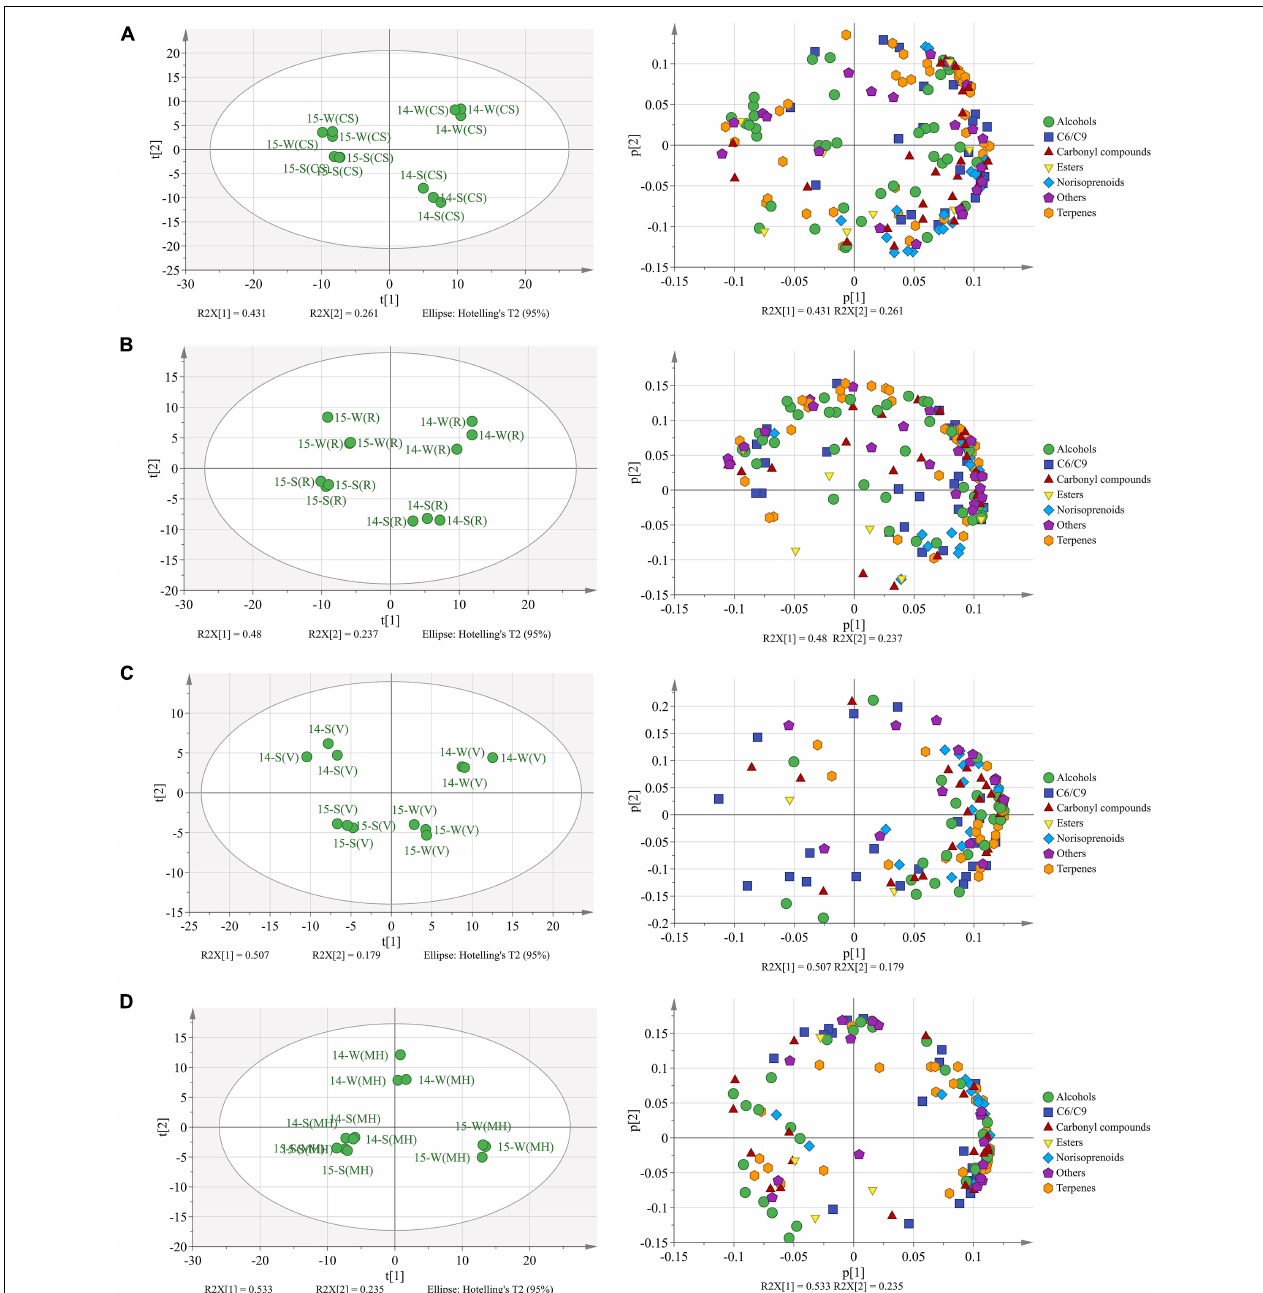
FIGURE 1 | The principal component analysis (PCA) based on the aroma compounds in Cabernet Sauvignon (A) , Riesling (B) , Victoria (C) , and Muscat Hamburg (D) grapes in 2014 and 2015. 14-S, 2014 summer season; 14-W, 2014 winter season; 15-S, 2015 summer season; 15-W, 2015 winter season.